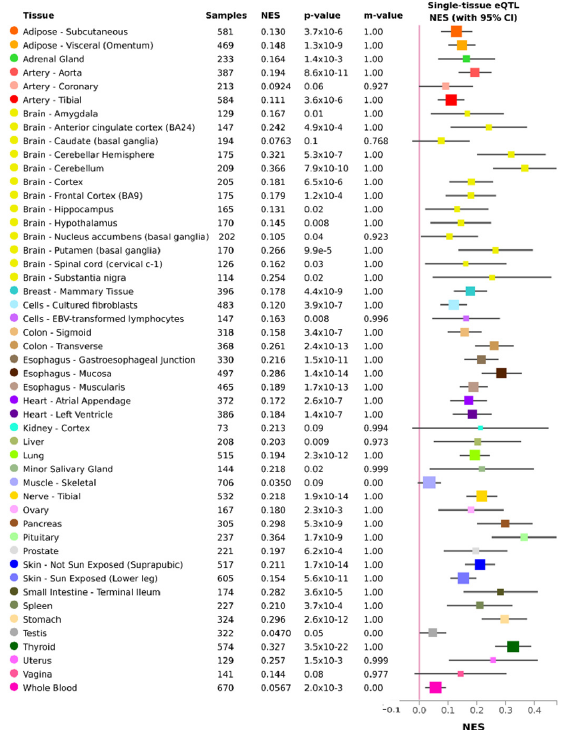
Figure 1. Multi-tissue eQTL (rs10419198) results from the query to GTEx portal. NES is the slope of the linear regression, computed as the effect of the alternative allele relative to the reference allele and m-value is the posterior probability that an effect exists in a